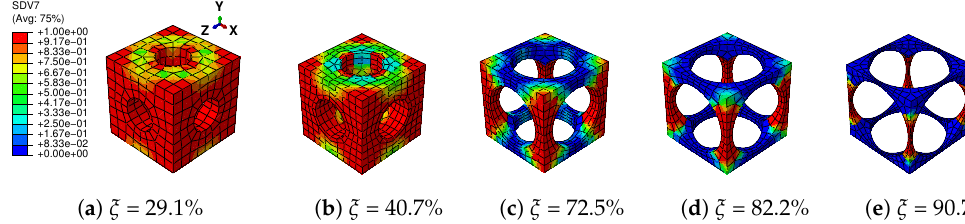
Figure 10. Distribution of martensitic volume fraction ¯ f t (named SDV7 in colorbar) on the RVEs with different void volume fractions ξ in tension loading at strain level